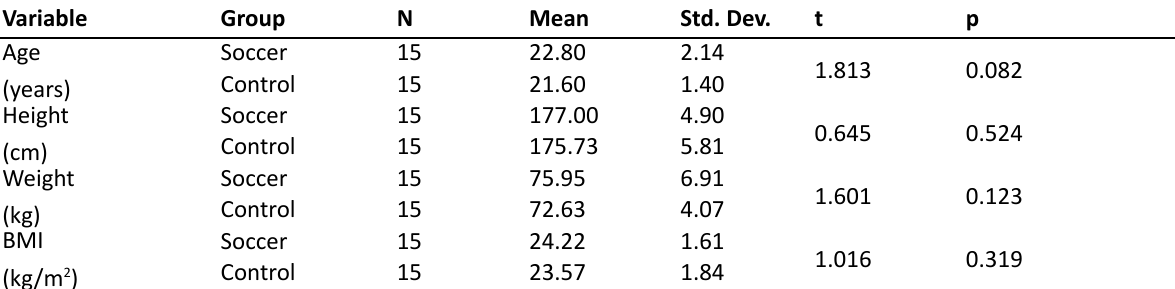
Table 1. Comparison of descriptive information of the football and control groups